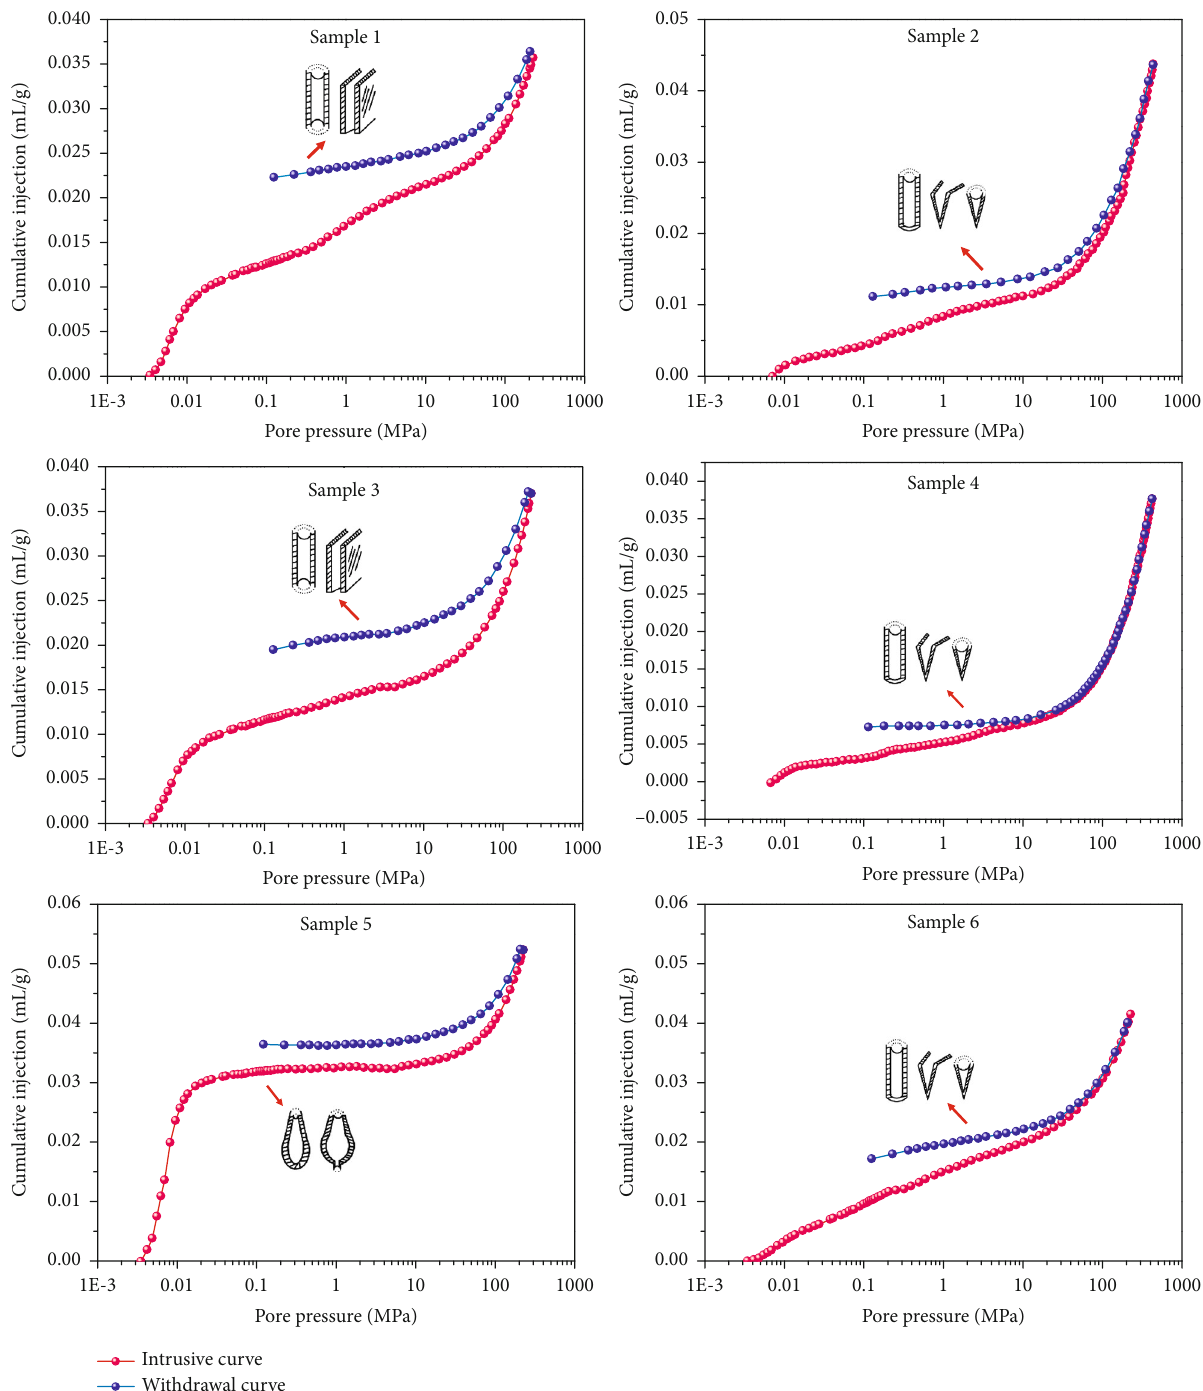
Figure 7: Mercury injection curves of experimental coal